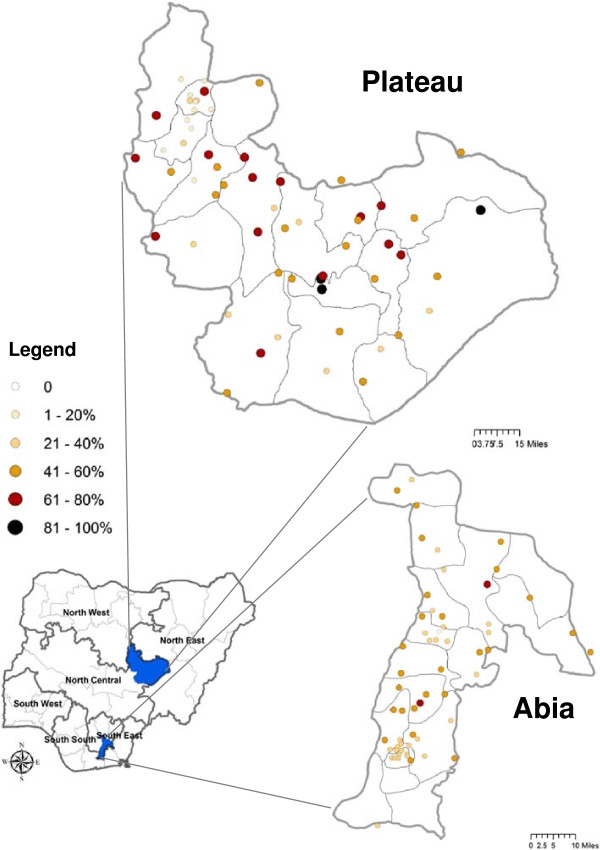
Study areas and Plasmodium prevalence by cluster. Plasmodium prevalence, diagnosed by microscopy, by survey cluster site in Abia and Plateau States, Nigeria. State maps outline their constituent local government areas (LGAs), while the national map highlights the six geo-political zones within Nigeria.